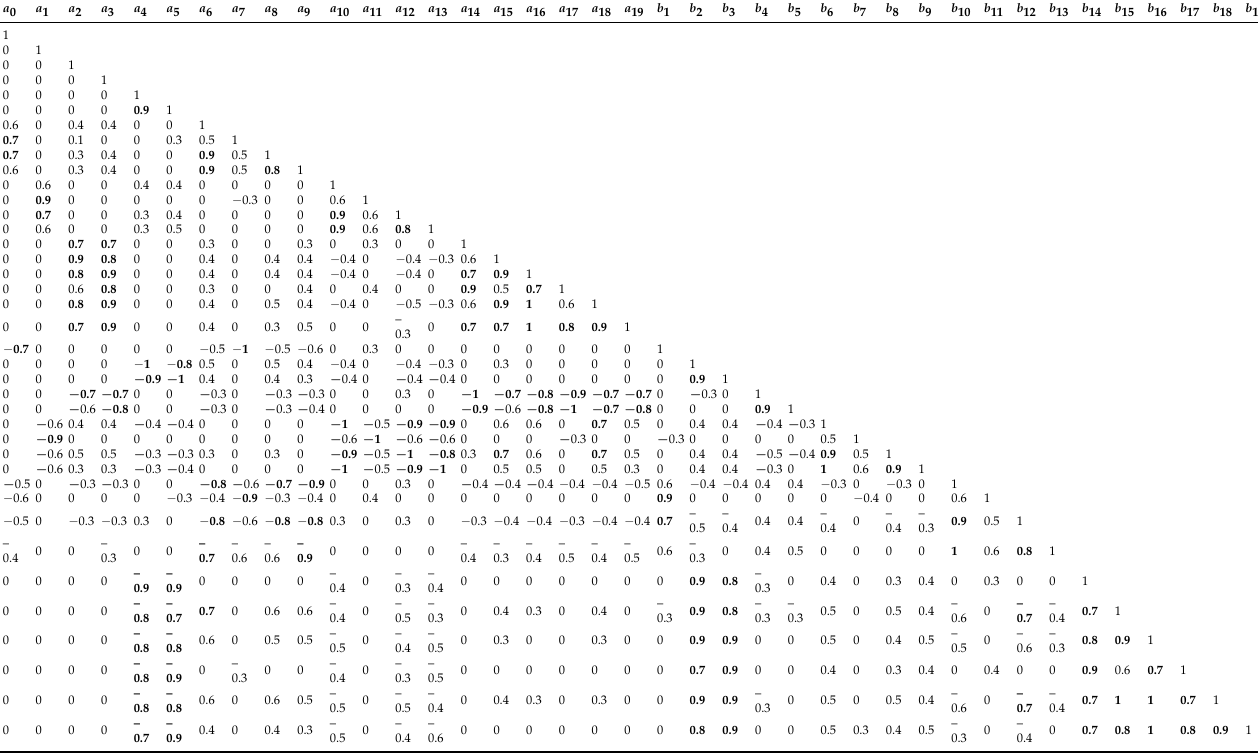
Table A1. Matrix of correlation coefficients between RPCs. (bold indicates correlation coefficients >